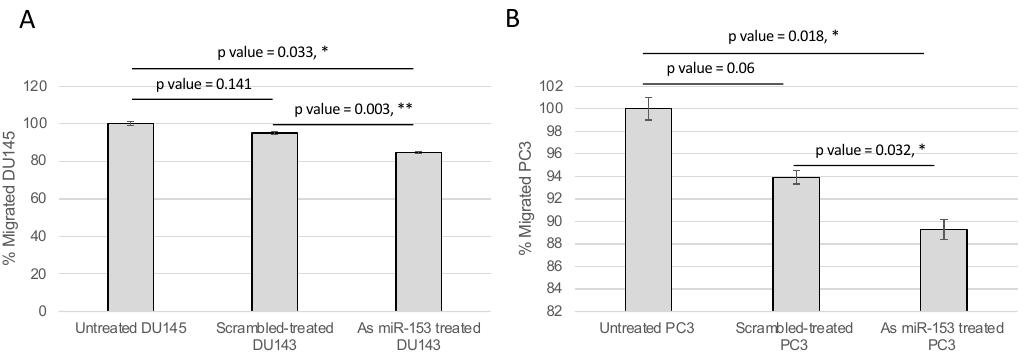
Figure 6. As miR-153 reduced the migration ability of both DU145 and PC3 cells. Calculation of the wound closure % in DU145 ( A ) and PC3 ( B ) cells treated with scrambled or As miR-153 oligonucleotides. Wound healing is calculated as: (area of the wound T = 24 h-area of the wound T = 0)/area of the wound T = 0. The treatment with As miR153 decreased the ability of the cell to close the wound, both compared to Scr-treated cells or to untreated cells. t Test p values are indicated ( n = 3 images for each sample in each time point; experiment performed in duplicate) ( t test, p value ≤ 0.05, *).